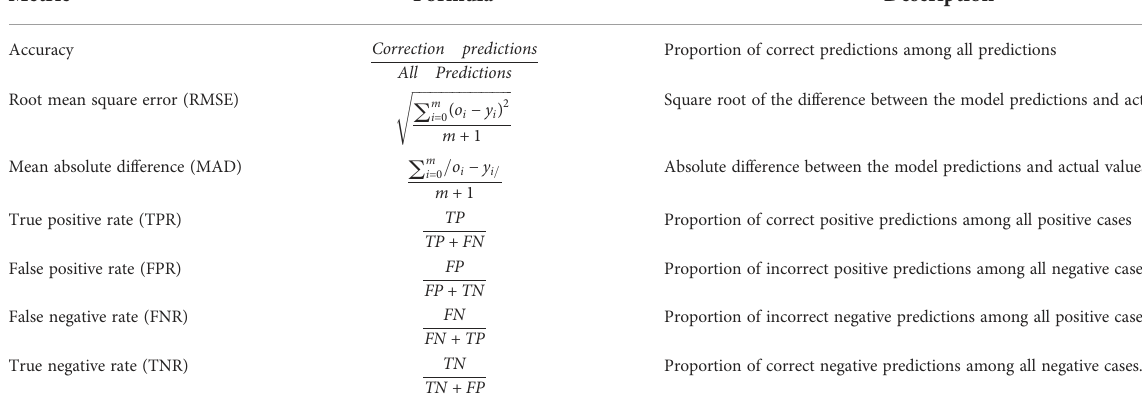
TABLE 2 Different performance metrics for classi fi cation